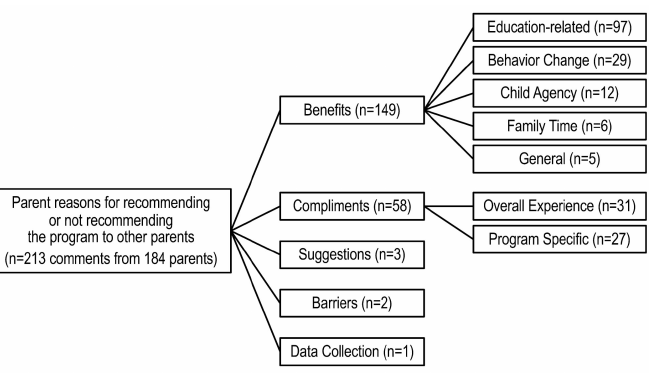
Figure 1. Reasons parents would or would not recommend the Butterfly Girls